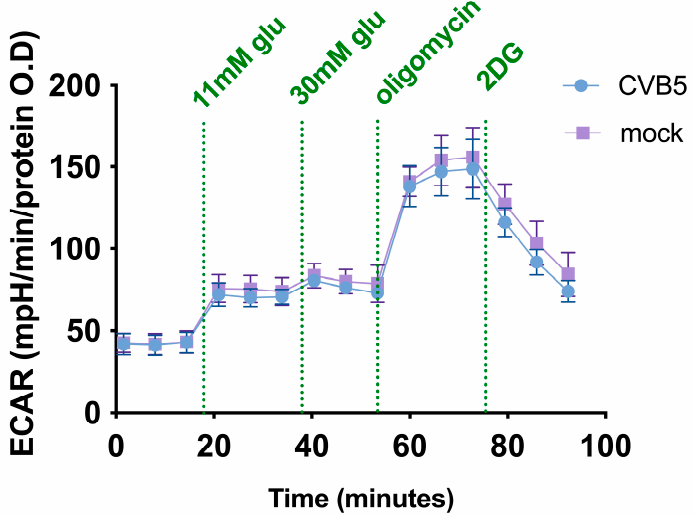
Figure 7. CVB5 does not affect the glycolytic activity of glioblastoma cells. DBTRG-05MG cells were infected with CBV5 at MOI 1, and the cells were subjected to GlycoStress assay according to manufacturer’s instructions at 7 h post-infection. In GlycoStress, glucose at final concentrations of 11 and 30 mM was followed by oligomycin (1 µ M) and 2DG (50 µ M) addition. Depicted values are means ± S.D.